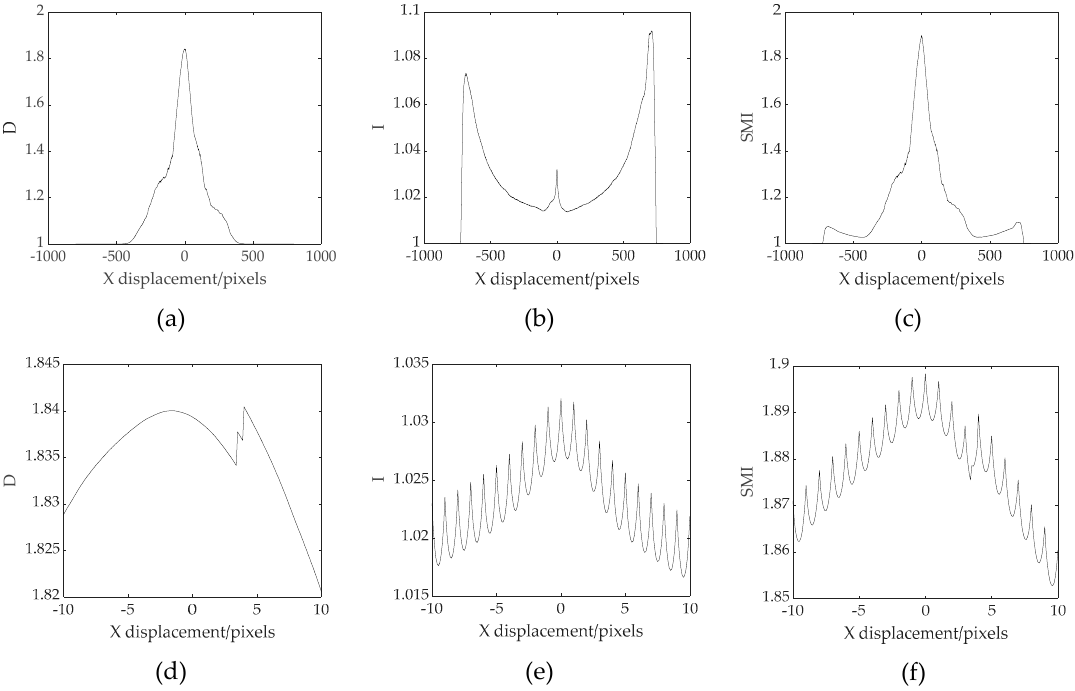
Figure 7. D, I, and SMI values under different horizontal translations between the manually registered images in Figure 6a. ( a – c ) are the D, I, and SMI values when the horizontal displacement is between [ − 800 800] at pixel intervals; ( d – f ) are the D, I, and SMI values when the horizontal displacement is between [ − 10 10] at 0.1 pixel intervals.